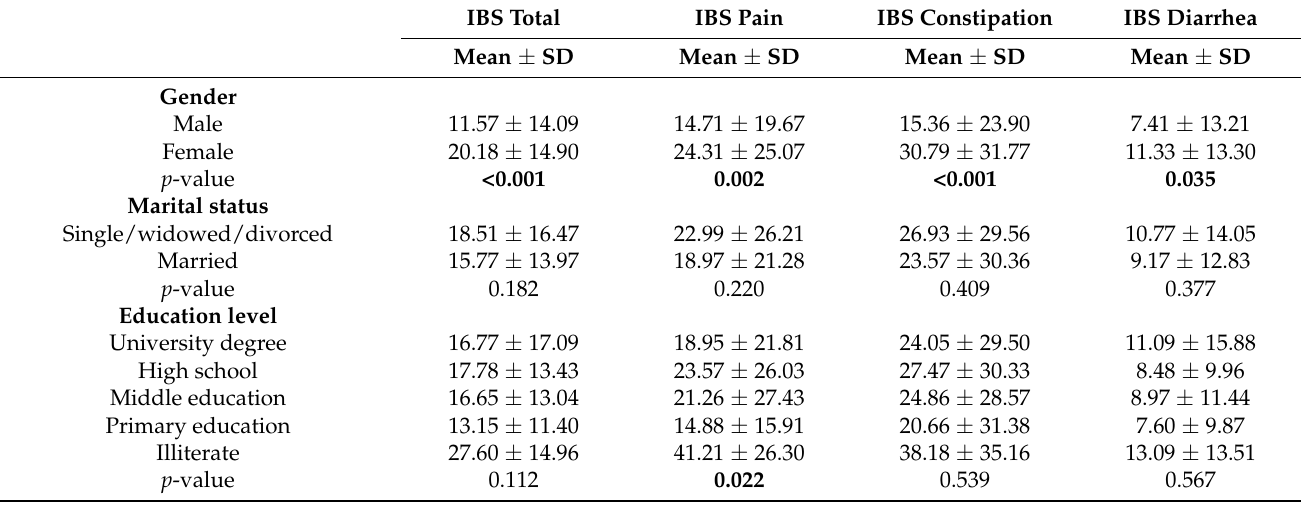
Table 3. Bivariate analysis taking the IBS total and subscores as the dependent